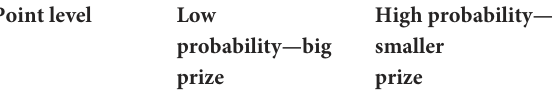
TABLE 2 Lottery prize compensation based on points earned in TMQQ component, viral suppression, and